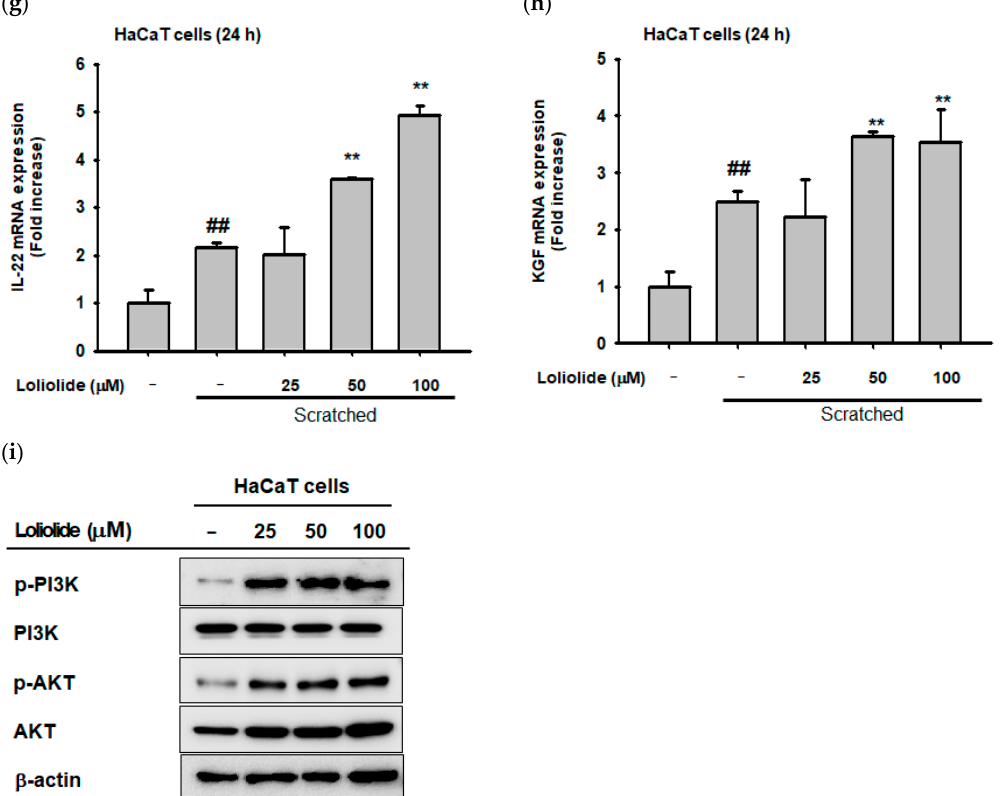
Figure 4. Effect of loliolide on cellular scratching, cell migration and inflammatory genes. ( a , b ) Cell migration in loliolide-pretreated scratched HaCaT cells. ( c ) Cell proliferation in loliolide-pretreated HaCaT cells. ( d – h ) RT-PCR ( d ) and real-time PCR ( e – h ) analyses of migration and inflammatory gene expression in loliolide-pretreated HaCaT cells. ( i ) Western blot analysis of the expression of epidermal growth factor receptor (EGFR) signaling pathway proteins in loliolide-pretreated scratched HaCaT cells. Statistical significance was evaluated using the Kruskal–Wallis/Mann–Whitney U test. ## p < 0.05 compared with the normal group (e–h: Loliolide − /Scratched − ), and * p < 0.05 and ** p < 0.01 compared with the control group (b and c: Loliolide − , and f, g, and h: Loliolide −